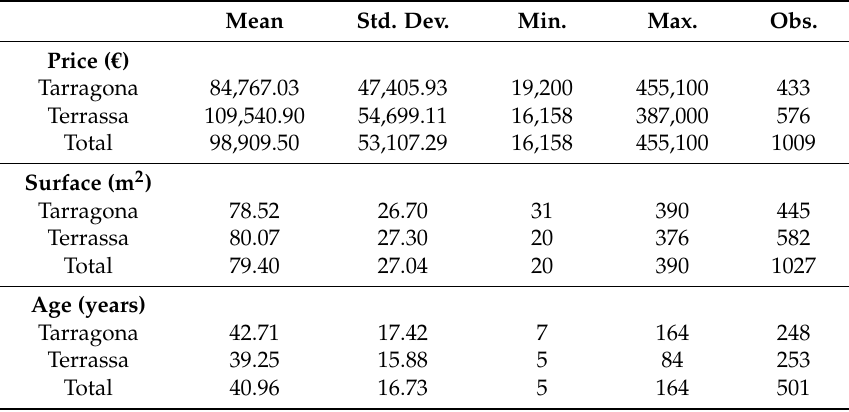
Figure 4. Vulnerable neighborhoods and Bivariate Moran’s LISA cluster maps for HOB/1000 housing units for census tracts and the unemployment rate ( upper ); and residents without primary studies ( lower ). Source: own elaboration. Table 5. Characteristics of HOBs in Tarragona and Terrassa.